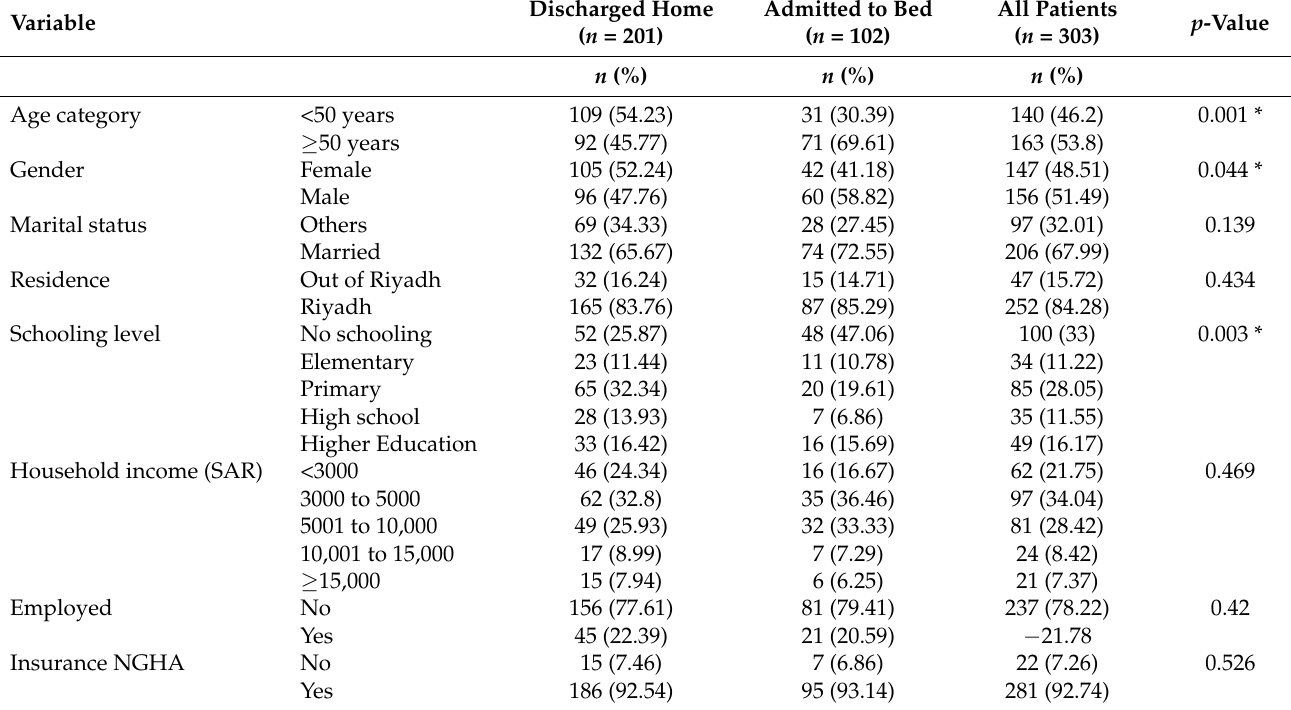
Table 1. Patients’ demographic, socioeconomic, and clinical characteristics by disposition